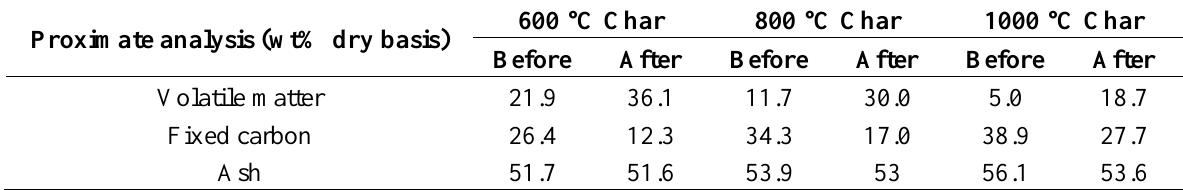
Table 5. Proximate analysis of each rice husk char adsorbent before and after tar adsorption. Proximate analysis (wt% dry basis) Before After Before After Before